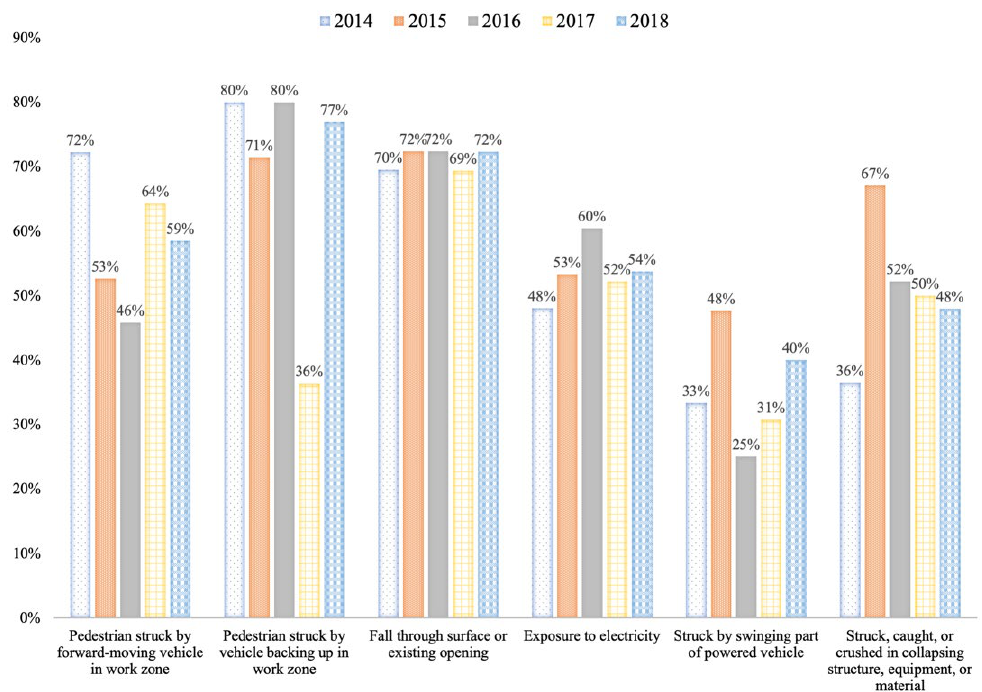
Figure 1. Certain events in the US construction industry have a very high fatality rate as compared to the yearly total fatalities occurring across all sectors [5]. the yearly total fatalities occurring across all sectors